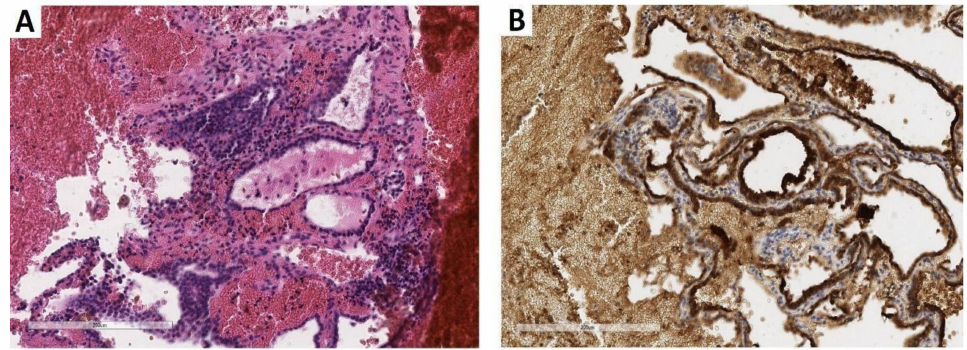
Figure 1. Core biopsy of the lumbar vertebral body. ( A ) The biopsy revealed thyroid-type tissue including well-differentiated follicles with colloid inside ( × 200; hematoxylin and eosin). ( B ) Follicular epithelial lining demonstrated marked thyroglobulin immunohistochemical expression ( × 200; clone EPR 9730, rabbit monoclonal, dilution 1:500, Abcam, Cambridge, UK) (previously unpublished, original